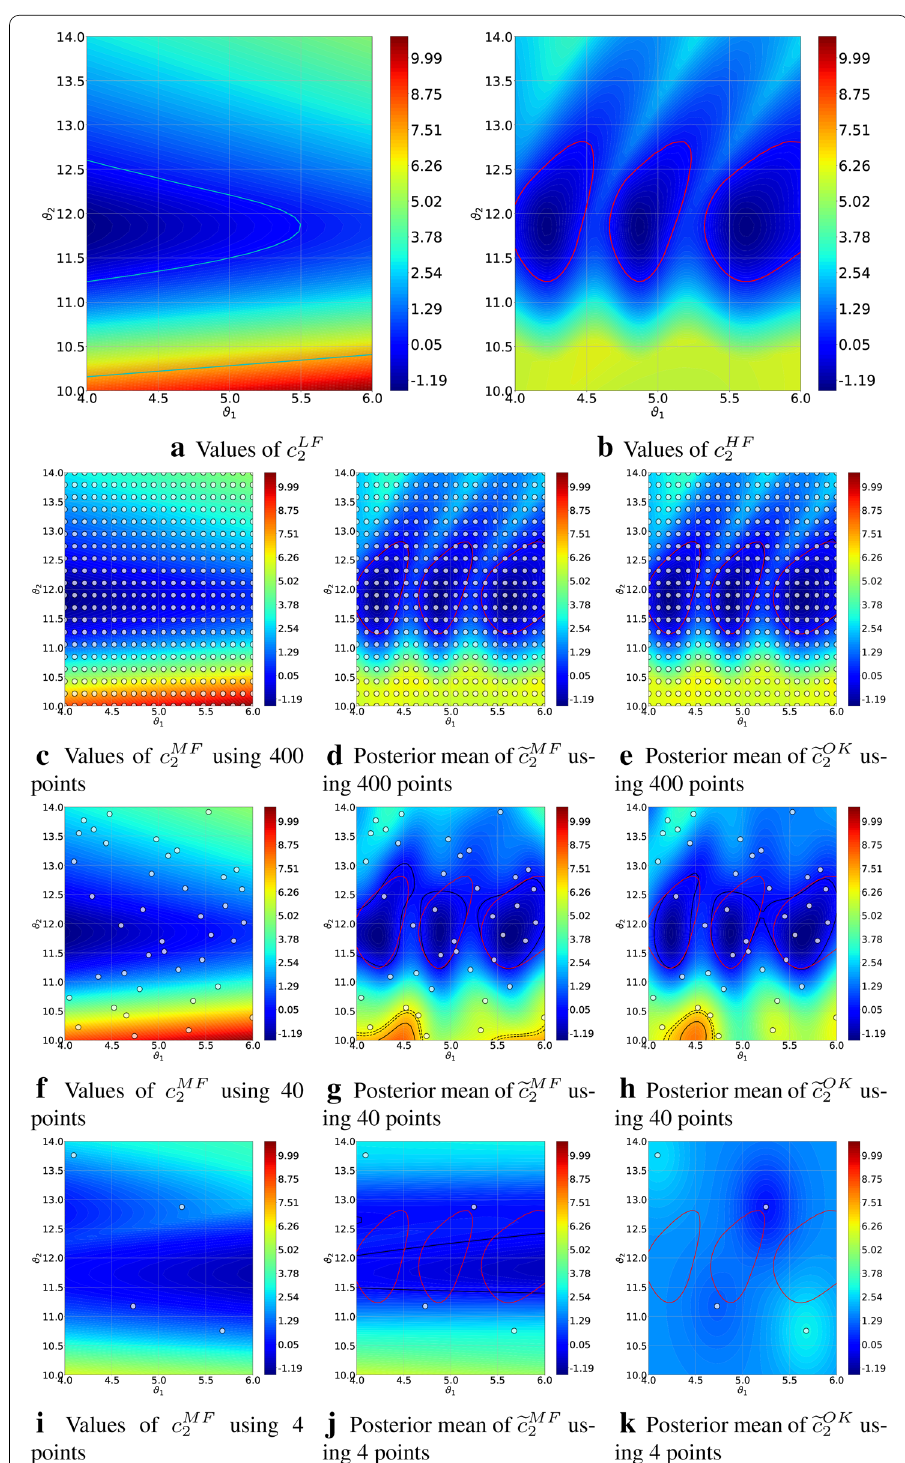
Fig. 5 The convergence of the MF trend, MF and OK models of c 2 . In c – h , the left, the middle and the right columns show the values of c MF